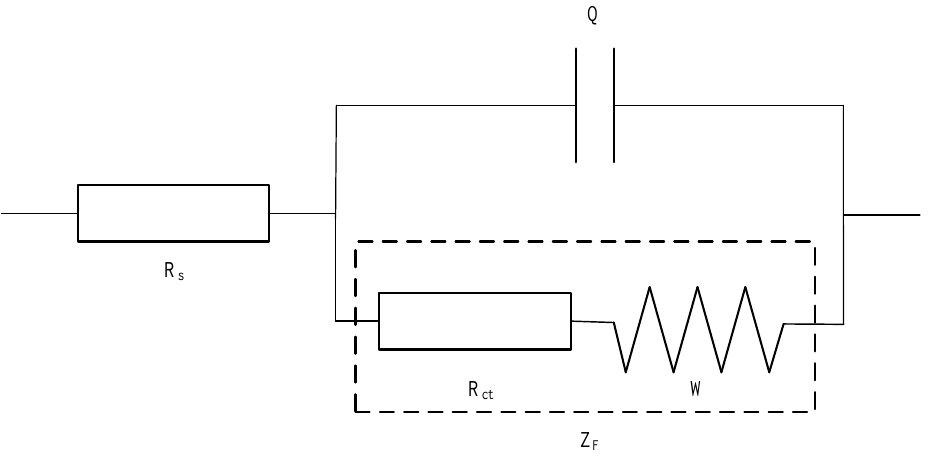
Figure 2. The Randles equivalent circuit for a general electrochemical